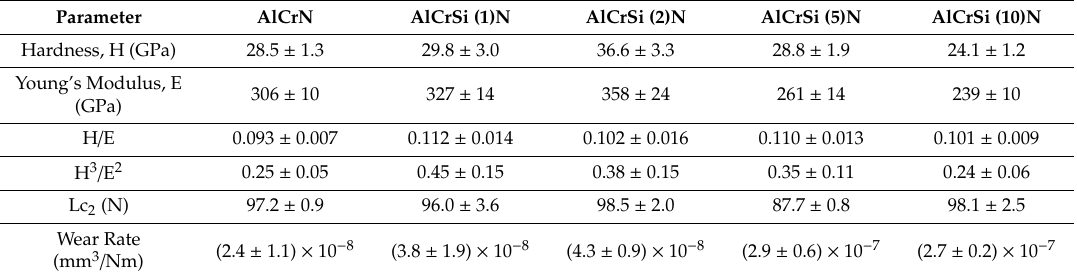
Table 2. Mechanical and tribological properties of the AlCrSiN